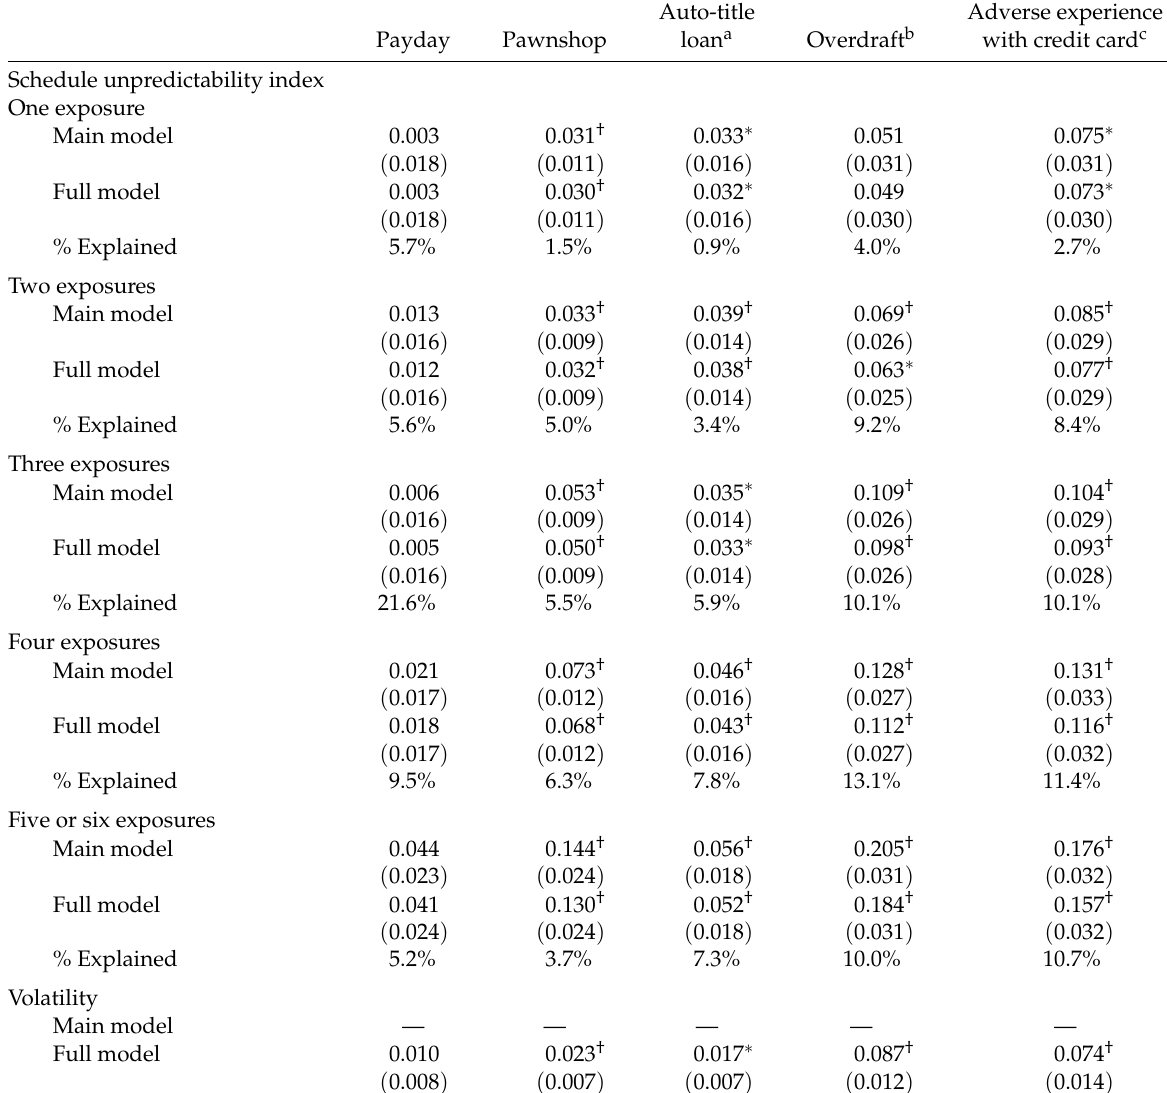
Table 5: Coefficients from main and full linear probability models